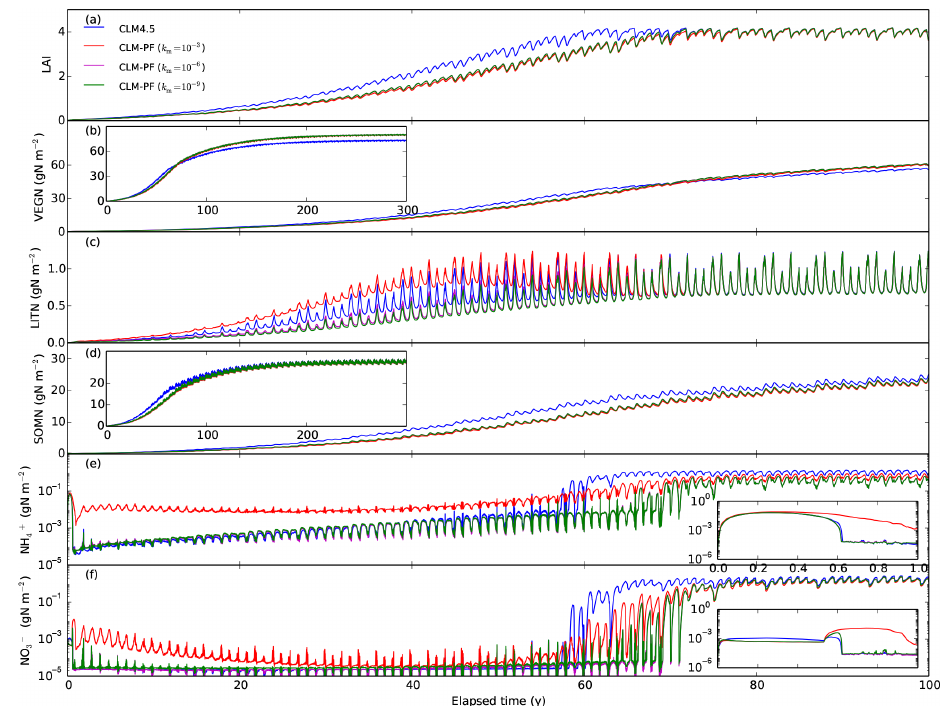
, and NO − pools in spin-up simulations for BR-Cax 4 3